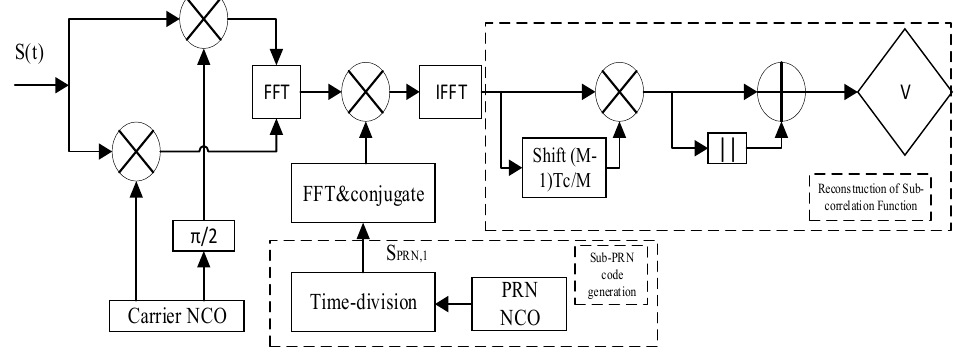
Figure 10. The SRSA acquisition schematic.